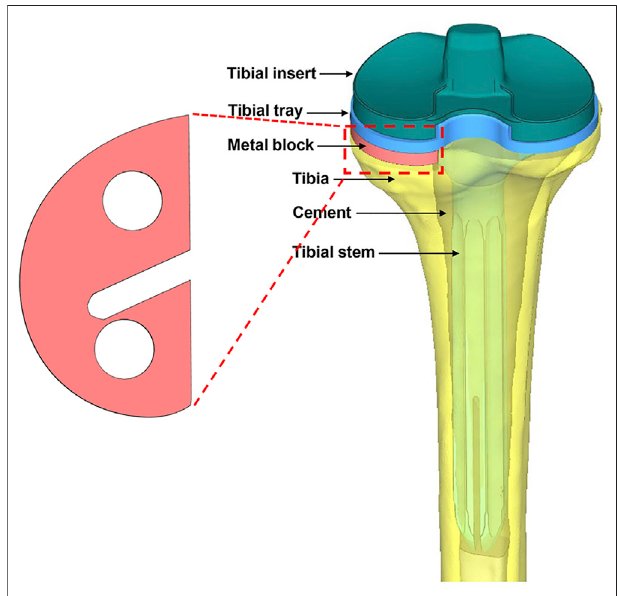
FIGURE 1 | Illustration of the metal block and the entire assembled model from the posterior view. The model consists of a tibial insert, tibial tray, tibial stem, metal block augmentation, bone cement, and